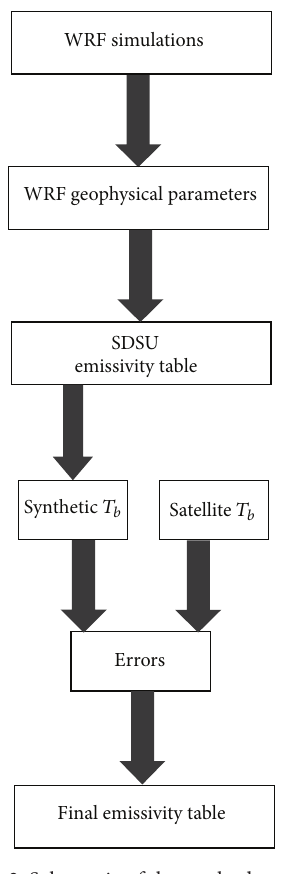
Figure 2: Schematic of the method proposed.